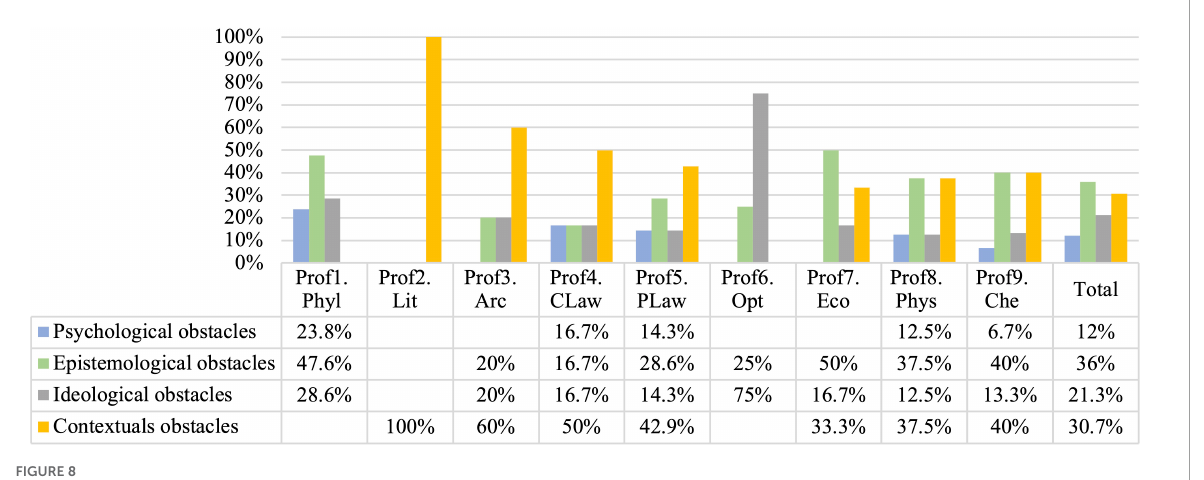
FIGURE8 Overall results obstacles.